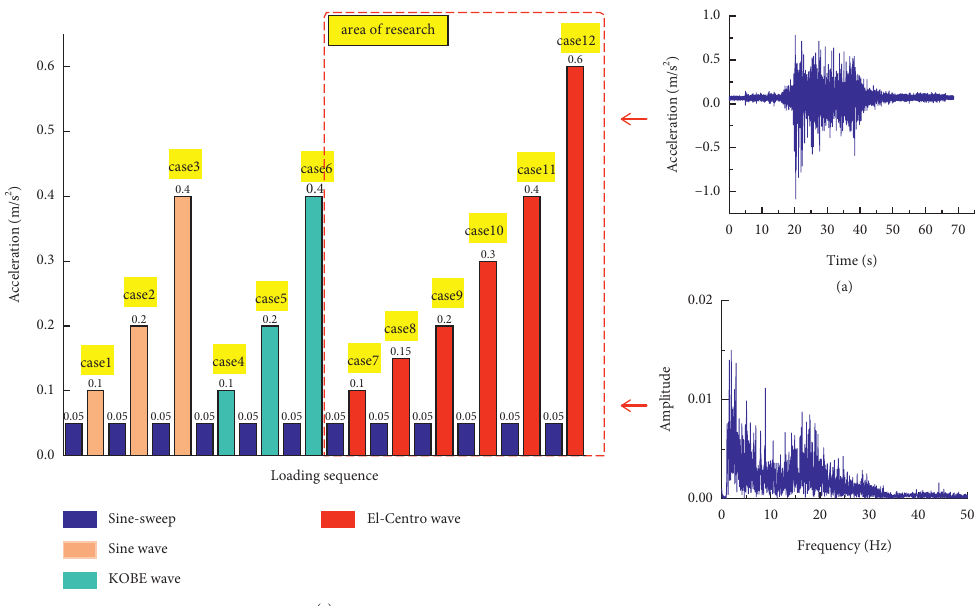
Figure 5: Loading condition design. (a) Time history of El Centro. (b) Fourier spectrum of El Centro. (c) Loading sequence of the shaking table test.